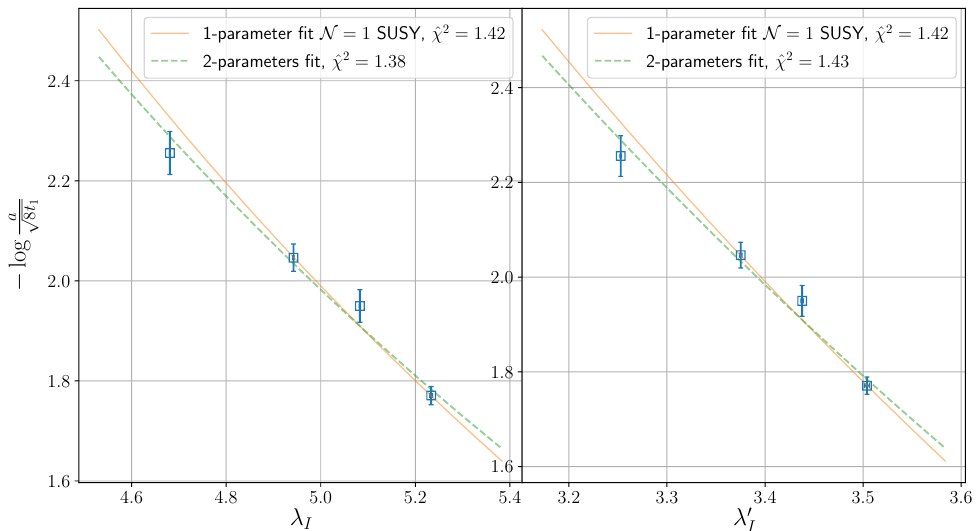
Figure 14. Dependence of the logarithm of the lattice spacing as a function of the improved coupling λ I defined in eq. (7.7) (left panel), and λ 0 defined in (7.8) (right panel). Points have been I fitted with eq. (7.6) leaving only Λ free (solid orange line), and with the same analytical form leaving also N f as a free parameter (dashed green